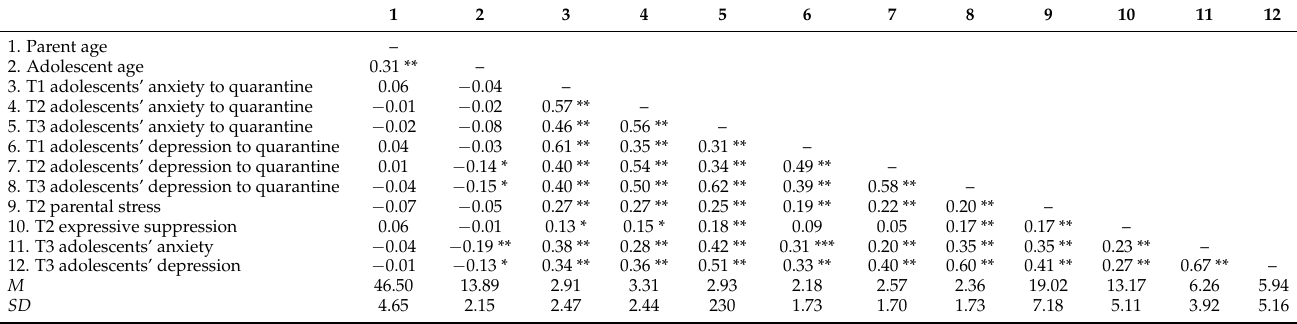
Table 2. Means, standard deviations, and bivariate correlations of the main variables ( n =